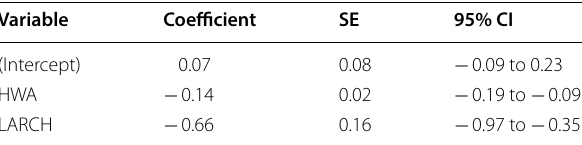
Table 3 Regression coefficients of the SW-to-HW model (after model selection)